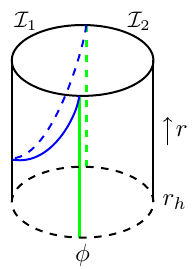
Figure 3 . Schematic illustration of island and HM surfaces. The black dashed line at the bottom is the horizon, the top the conformal boundary. The region between the green and blue curves is the